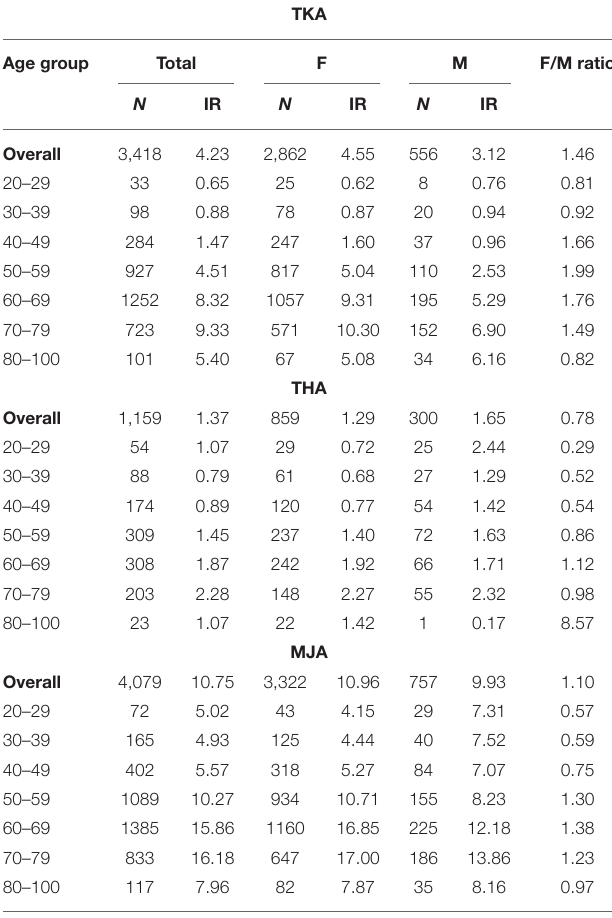
TABLE 1 | Demographic characteristics and comorbidities of patients newly diagnosed rheumatoid arthritis (RA) in Taiwan from 2000 to 2013. Variable RA Patients ( n = 35,219)